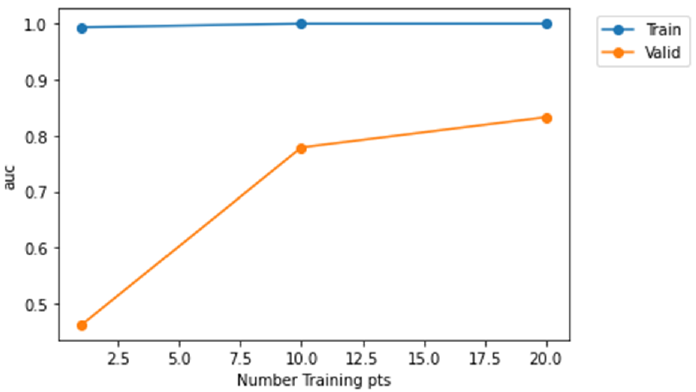
Figure 14. Representation of AUC values at different training points for Model-2.